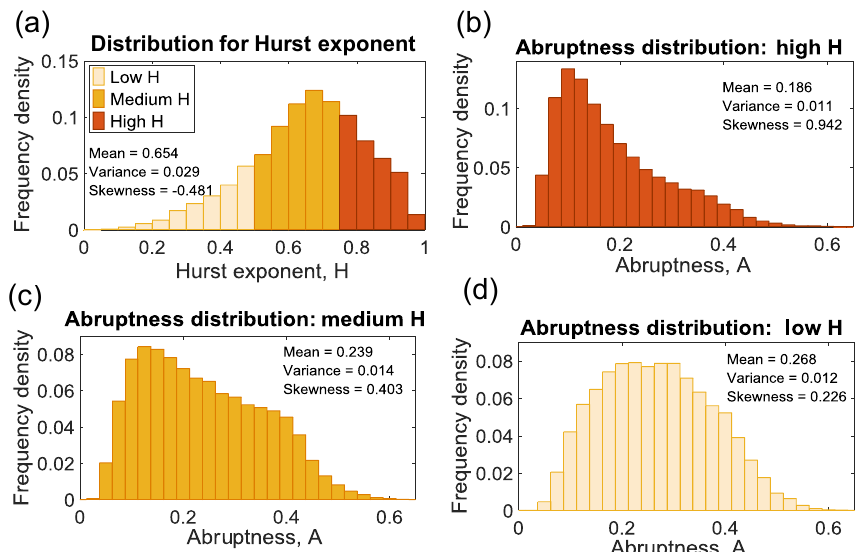
Figure 7. Relationship between Hurst exponent, H , and waveform abruptness, A (corresponding to flight-track data in Fig. 6). (a) Total distribution for Hurst exponent. (b) Abruptness distribution for high H , ( H > 0.75). (c) Abruptness distribution for medium H , (0.5 < H ≤ 0.75). (d) Abruptness distribution for low H , ( H ≤ 0.5). The observed distributions in (b) , (c) , and (d) confirm the theoretical prediction